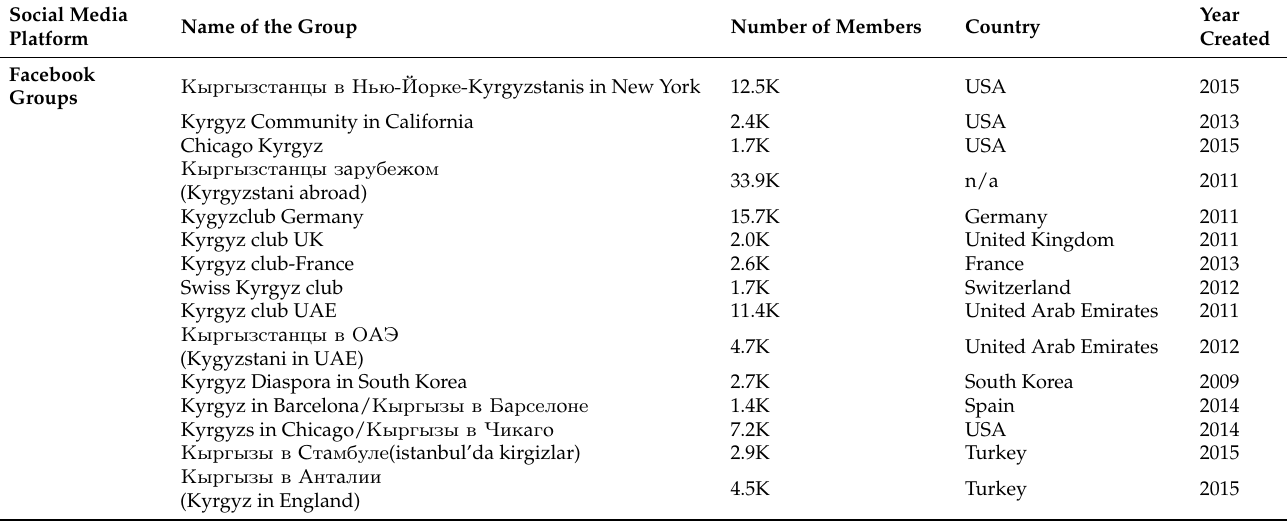
Table 1. Social Media Groups or Communities Included in the